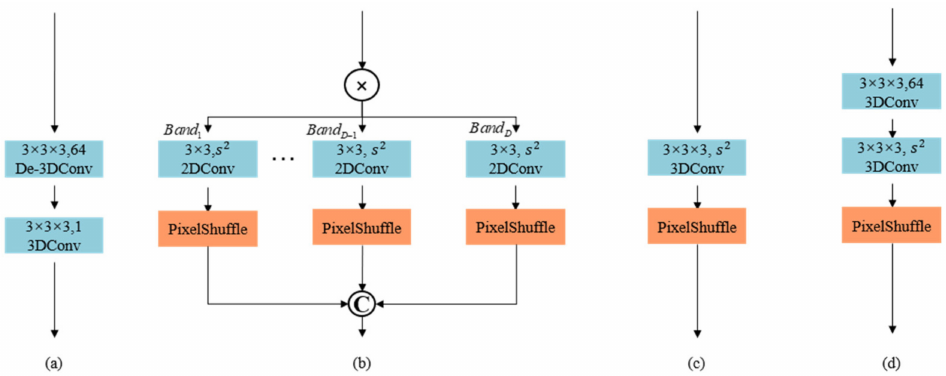
Figure 5. Architecture of various the image reconstruction networks. The first parameter of con- volution means the kernel size, the second parameter of convolution means the output channel. ( a ) Commonly used 3D convolution reconstruction structure ( b ) Sub-pixel convolution in 2D form. ( c ) Sub-pixel convolution in 3D form. ( d ) Optimized sub-pixel convolution in 3D